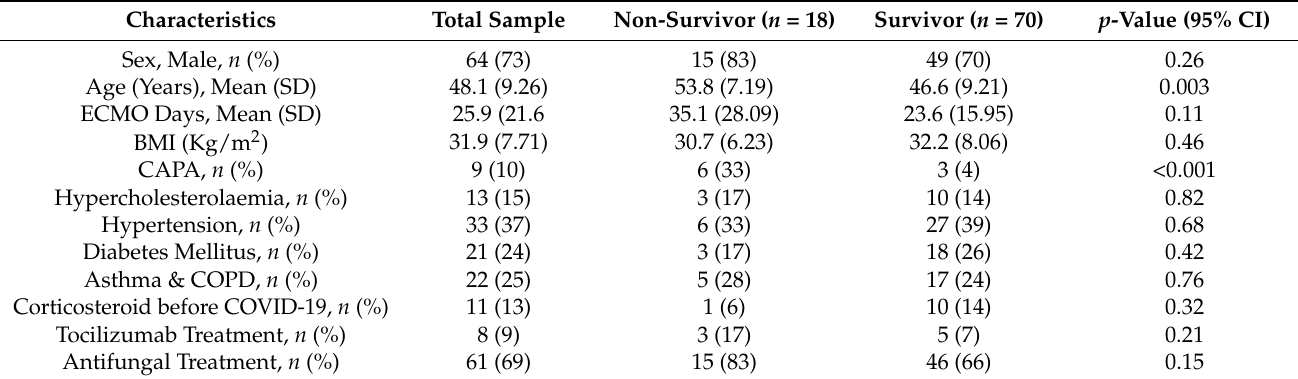
Table 3. Baseline characteristics of non-survivor (death) and survivor